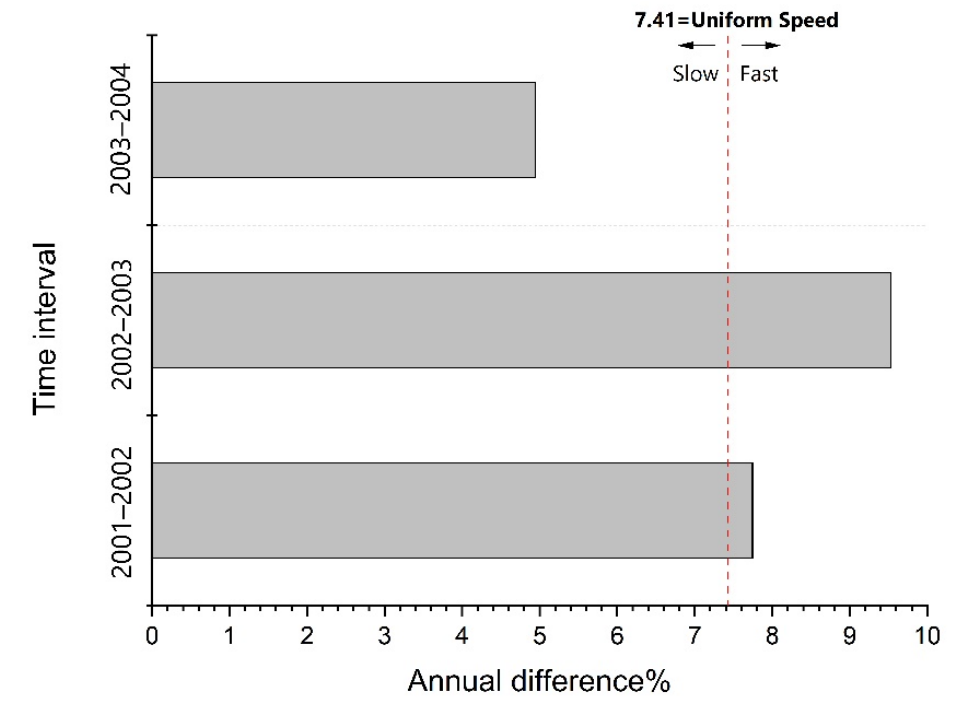
Figure 6. Intensity changes during three time intervals in L–S Creek watershed.